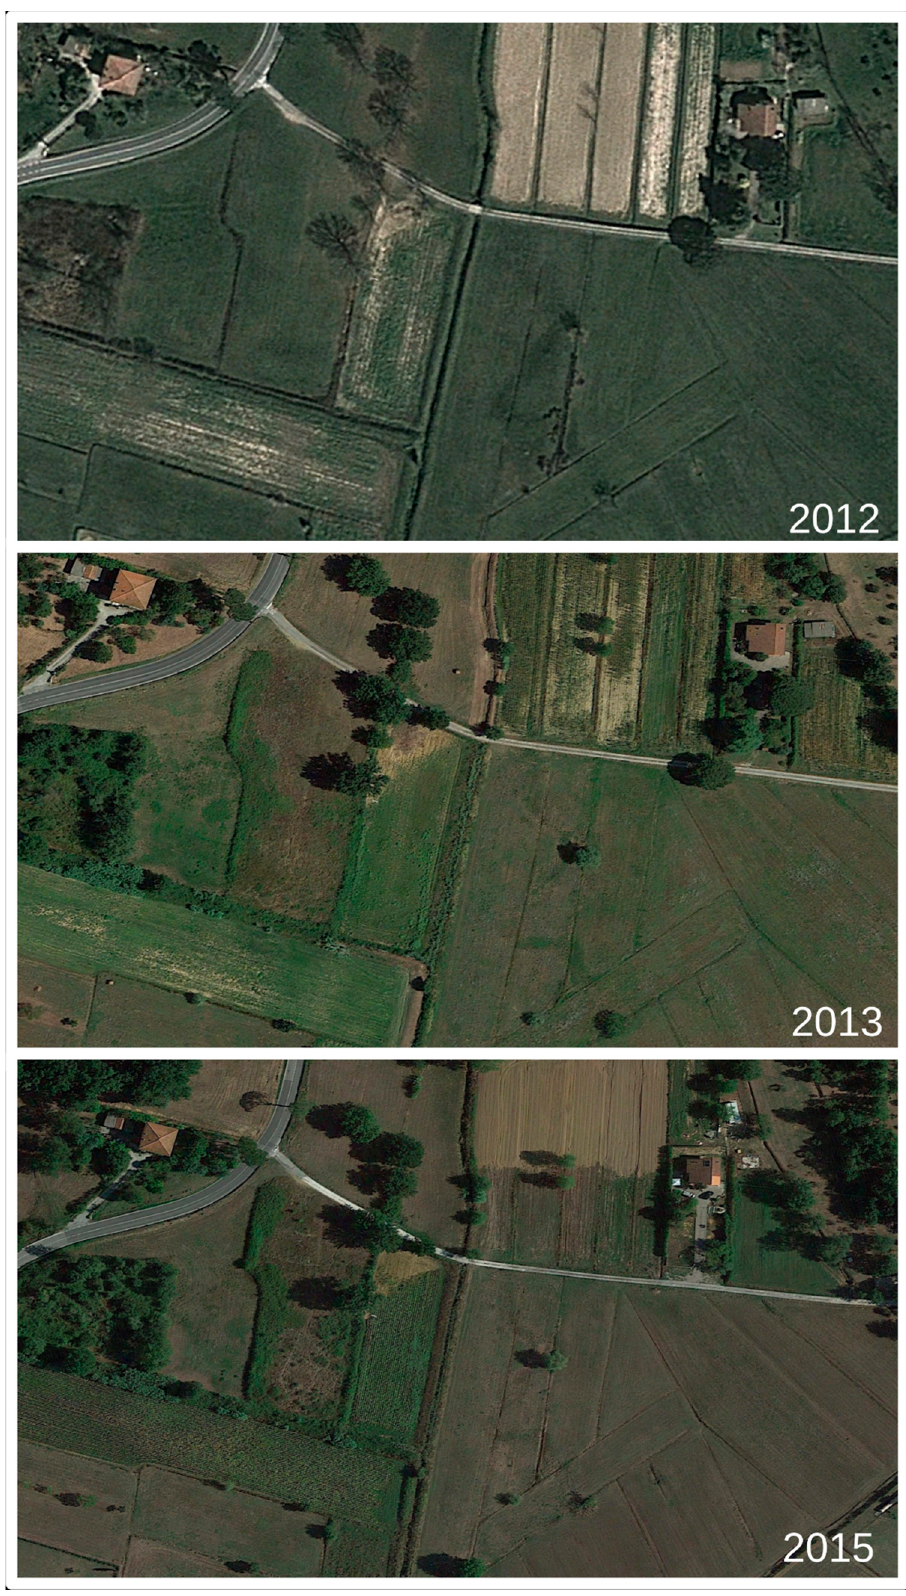
Figure 1. Map of the site from 2012 to 2015, to highlight the cultivation before the abandonment of one portion.